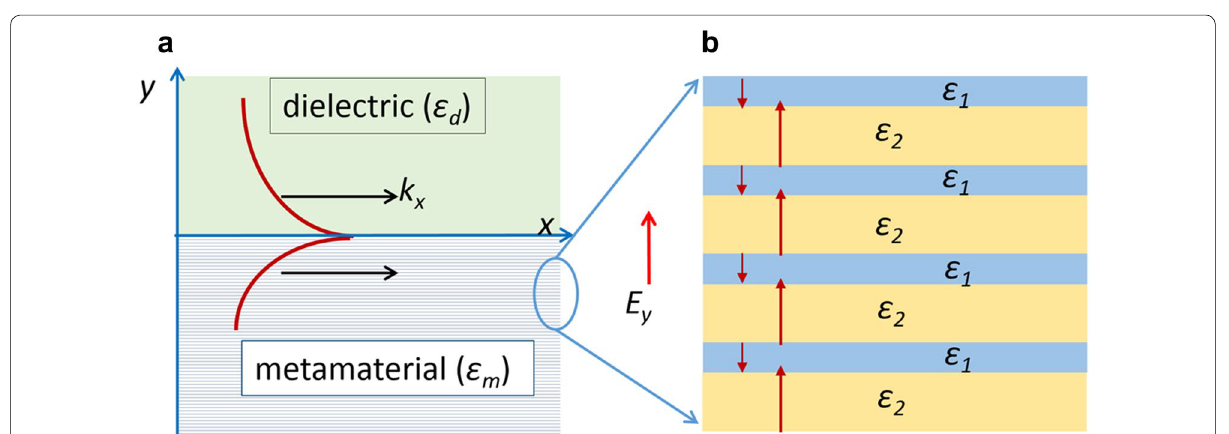
Fig. 1 Surface-bound wave propagation at an interface of hyperbolic metamaterial ( ε m ) and isotropic dielectric ( ε d ). a Schematic of surface-plasmon field distribution. b Hyperbolic metamaterial composed of metal ( ε 1 ) and dielectric ( ε 2 ) thin-film multilayer stacked